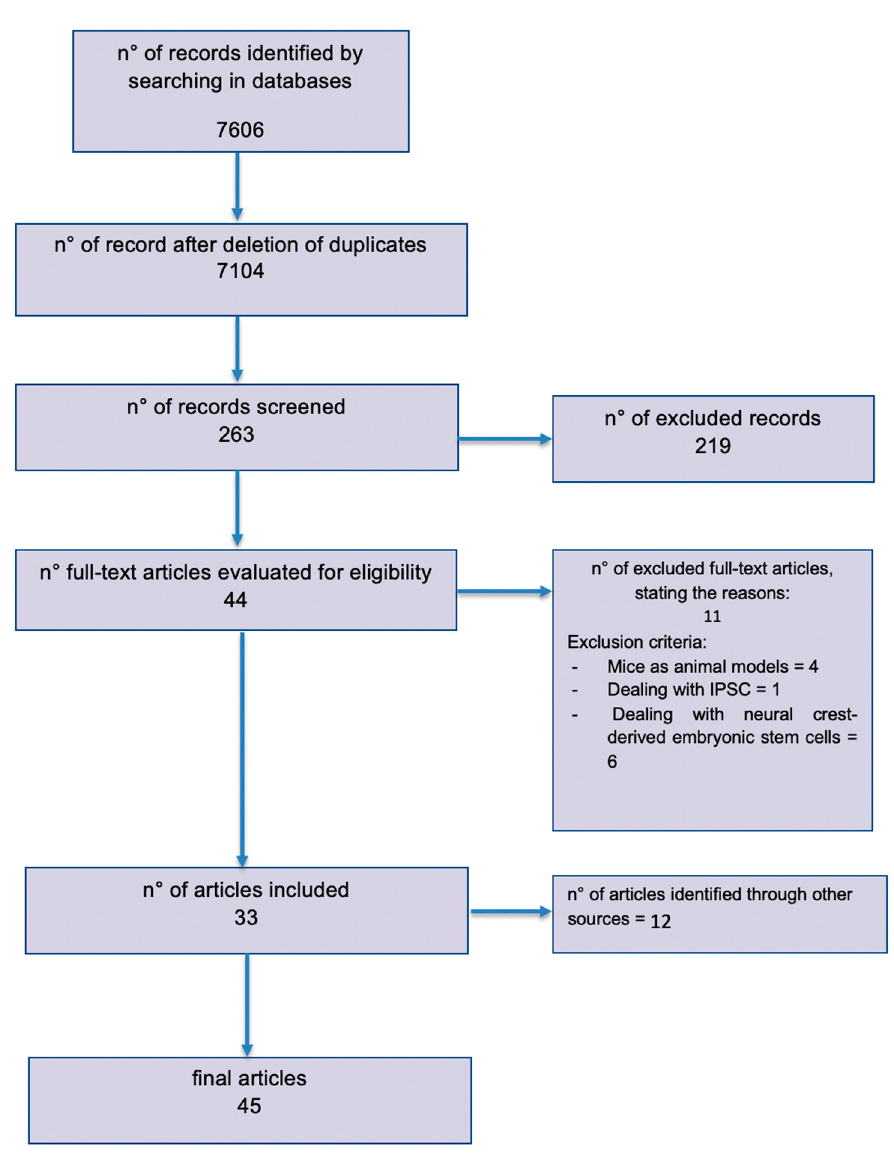
Figure 2. Preferred Reporting Items for Systematic Reviews and Meta-Analyses (PRISMA) flow diagram outlining the systematic review process.